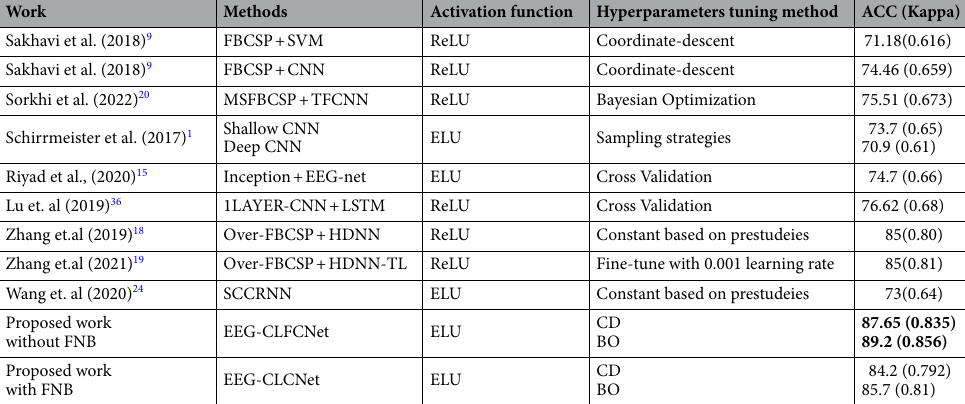
Table 5. Contrast with the advanced methods and baseline methods. All the methods are relied on the BCI Competition IV-2a datasets. Values in parenthesis are kappa value and the nonparanthesis are accuracy values. Significant values are in